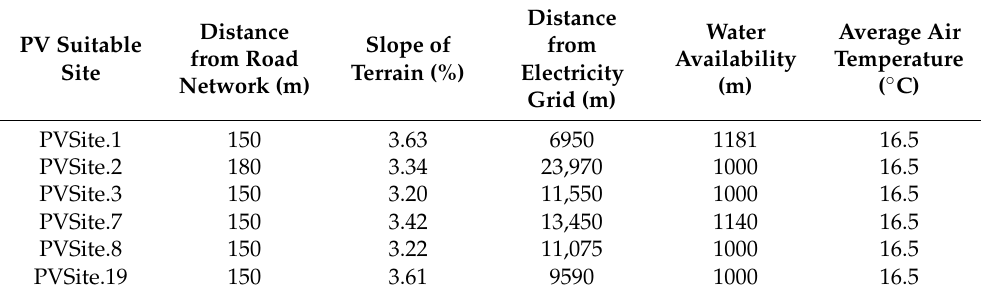
Table 8. The characteristics of the proposed highly suitable sites for PV farm installation according to the cost